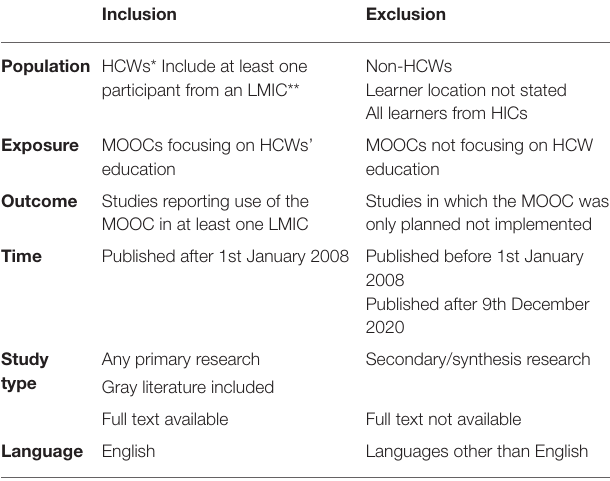
TABLE 2 | Inclusion and exclusion criteria based on the population-exposure-outcome